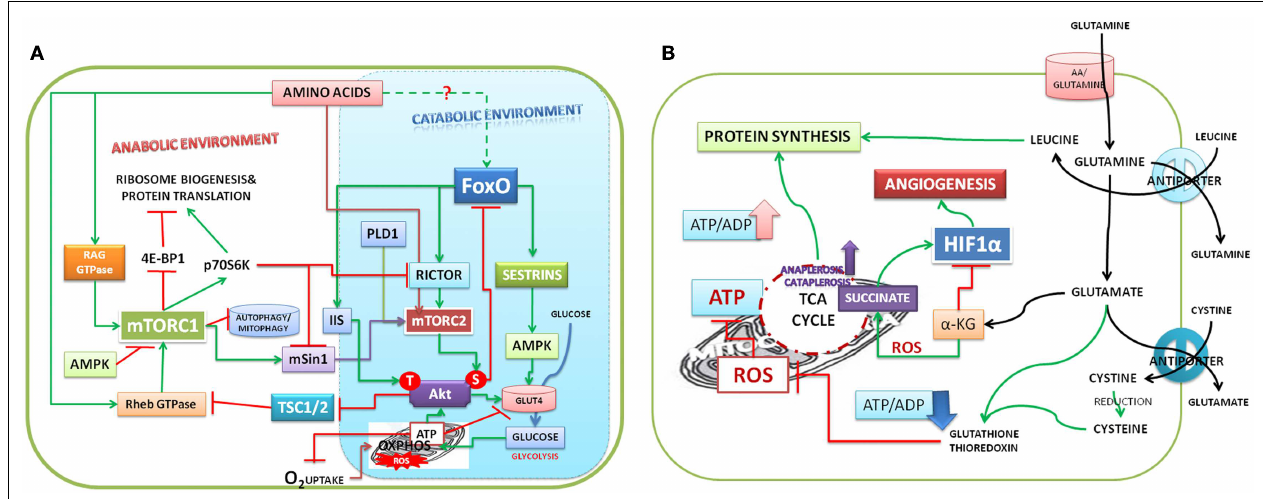
autophagy and mitophagy by mTORC1 shifts the mitochondrial function from ATP production to supply of amino acids, citrate for biosynthesis of proteins/lipids. (B) Model depicting the role of glutamine in mitochondrial function and anabolic environment in cells: glutamine entering into cells is hydrolyzed to generate glutamate by glutaminase. Glutamine – leucine antiporter promotes the uptake of leucine, which activates mTORC1 and protein synthesis. Glutamate has multiple functions; uptake of cystine in exchange for glutamate promotes glutathione biosynthesis, which regulates ROS. ROS accumulation inhibits ATP production. Glutamate replenishes α -ketoglutarate ( α -KG) to Krebs cycle and promotes ATP production and inhibits HIF1- α . ROS promotes non-enzymatic decarboxylation of α -KG to succinate, which is an activator of HIF1- α , glycolysis, and